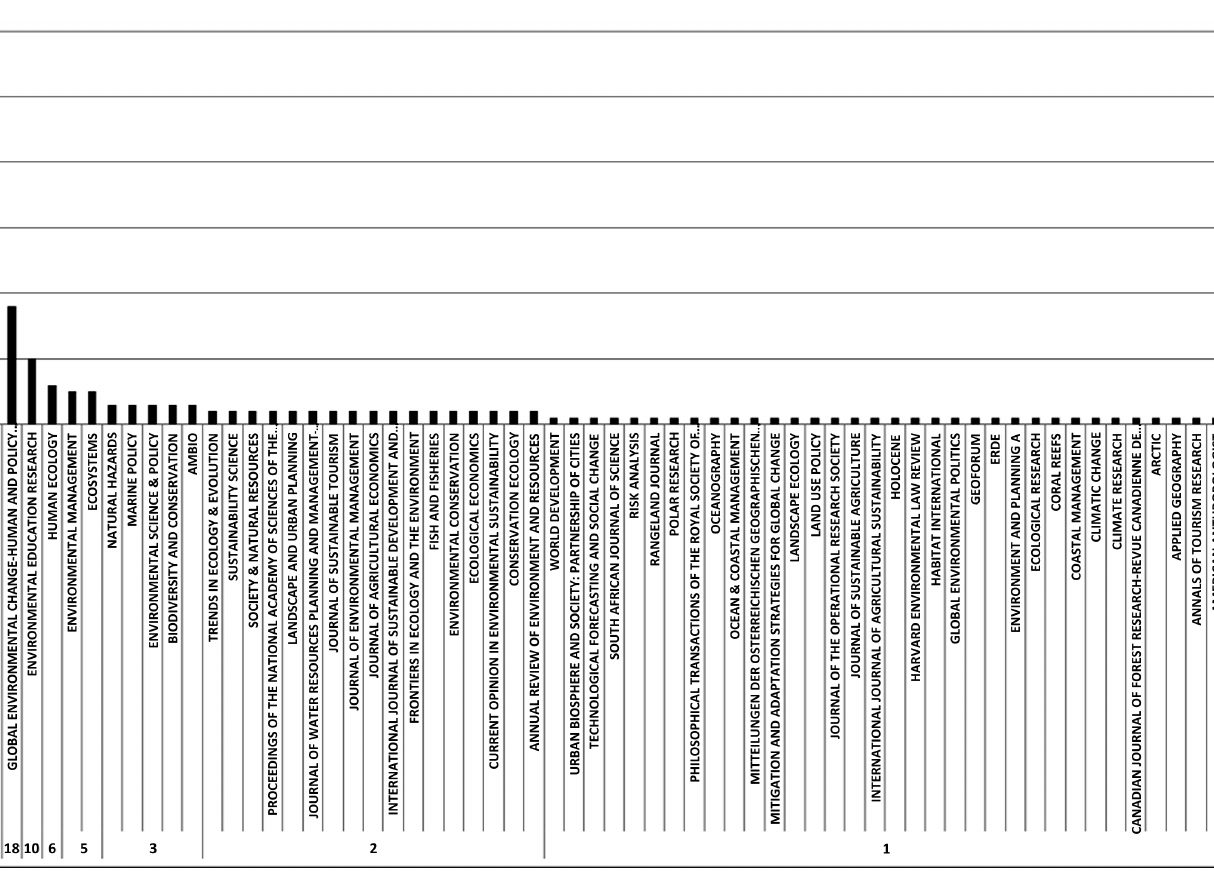
Fig. 1. The 62 journals of the 183 papers for the years